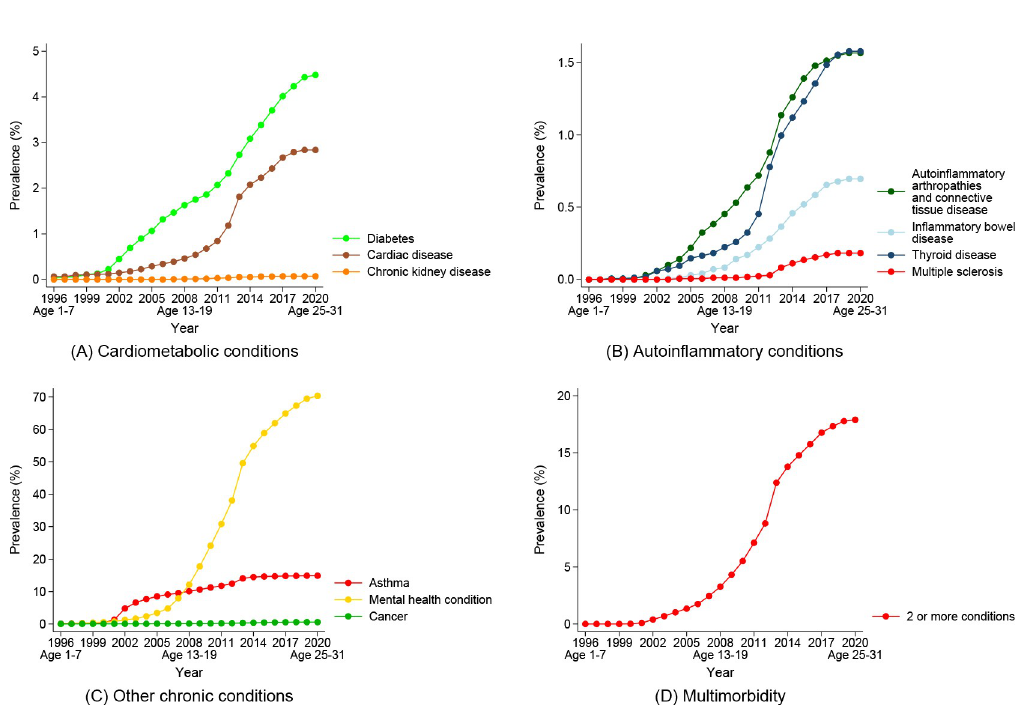
Fig 6. Prevalence of chronic conditions over time for women born 1989–95 from the Australian Longitudinal Study on Women’s Health.